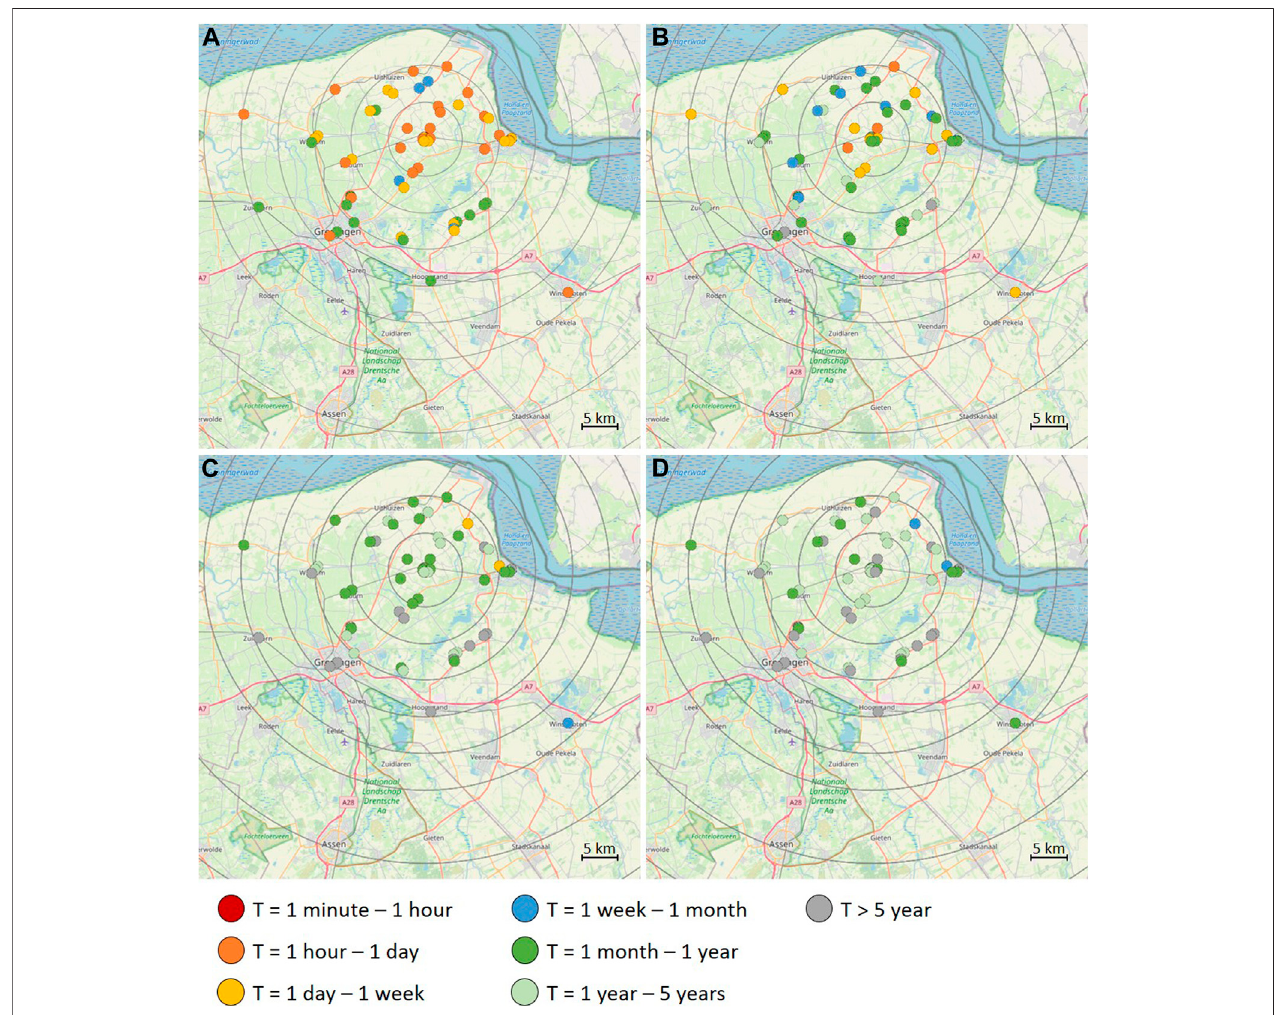
FIGURE9| Returnperiodsdeterminedfromtheheartbeatdataofthefulloperationalperiodforvelocitythresholds: (A) v (cid:1) 0.3mm/s, (B) v (cid:1) 1mm/s, (C) v (cid:1) 3mm/s and (D) v (cid:1) 5 mm/s.